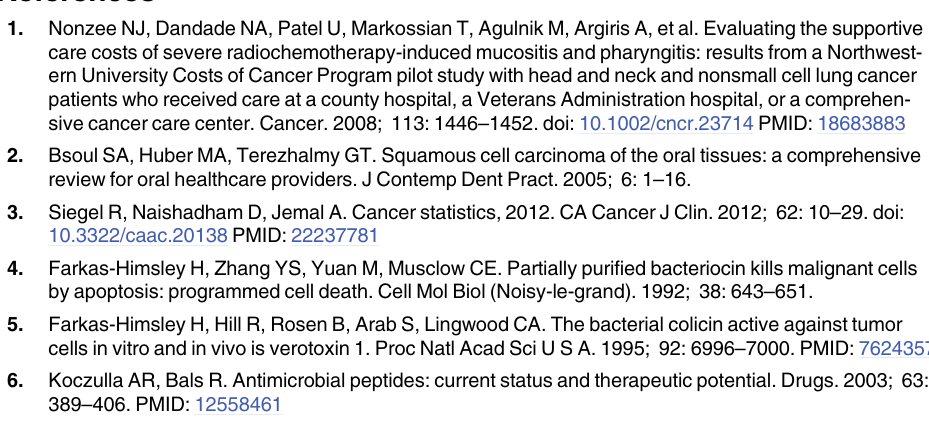
S1 Fig. Nisin treatment decreases cdc2 phosphorylation in HNSCC cells. Western blots showing that nisin treatment (80 μ g/ml nisin 2.5% purity; 24 h) decreases phosphorylation of the cell cycle checkpoint marker, cdc2, in HNSCC cells (UM-SCC-17B) compared to control/ media treatment. A western blot for cdc2 shows that total protein levels for cdc2 do not